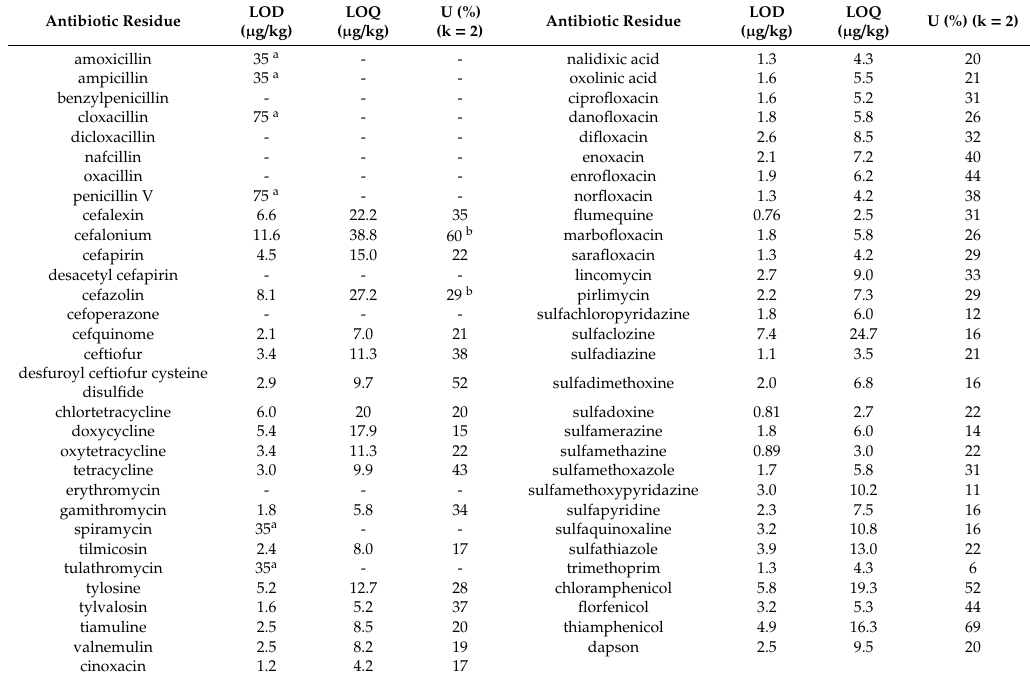
Table 8. Overview of the limit of detection (LOD), limit of quantification (LOQ), and